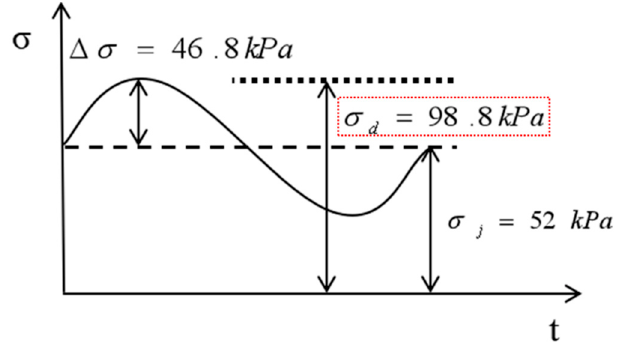
Figure 9. Stress–time curve.